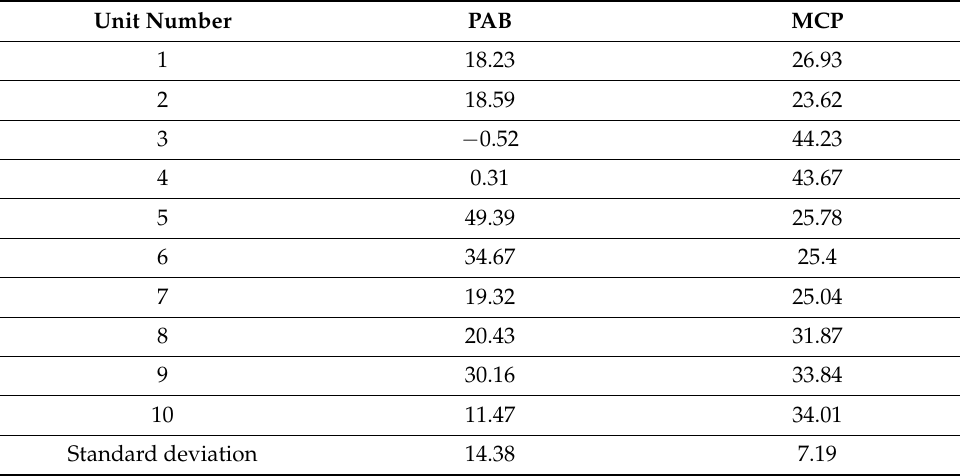
Table 6. Average change in unit revenue under changes in supply and demand.